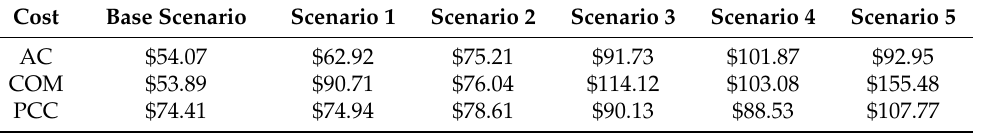
Table 8. Cost of treatment over 20 years for five different scenarios (in millions of dollars).